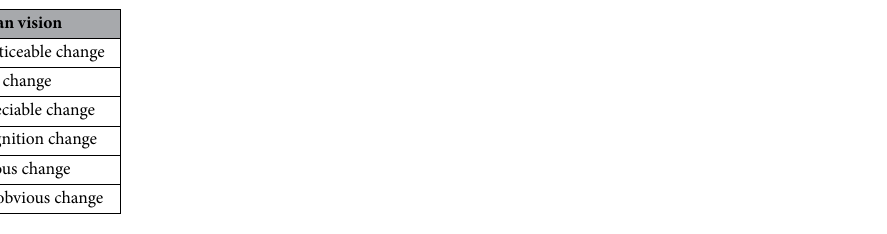
Table 3. The relation between ∆E ab and identification ability of human